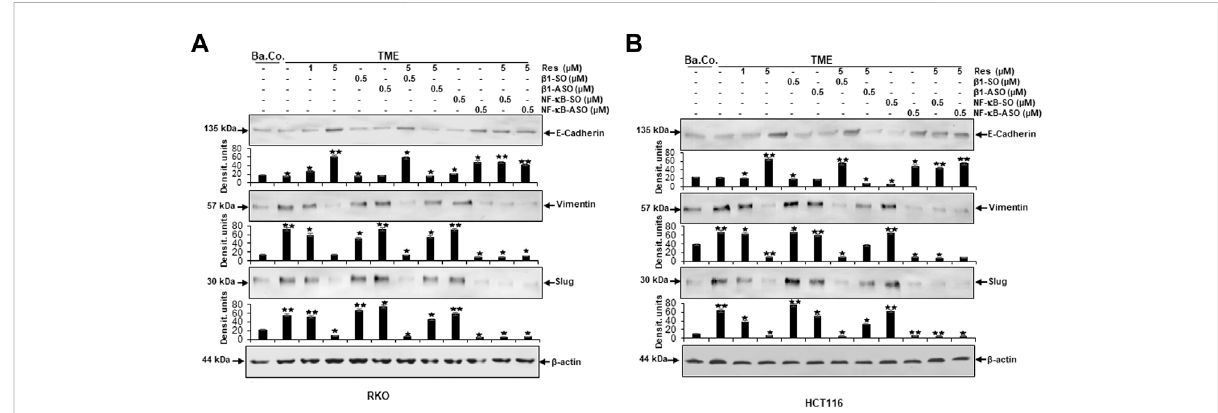
FIGURE 8 Impactofresveratrolor/andASOagainst β 1-integrinoragainstNF- κ BonTME-promotedactivationofEMT-linkedbiomarkersinCRCcells.3D- alginate RKO (A) and HCT116 (B) CRC cells were detected against E-cadherin, vimentin, slug and loading controlled with β -actin after 10 – 14 days of treatment. X -axis:untreated(Ba.Co.),TMEcontrol,resveratrol(1,5 µM), β 1-SO/ASO(0.5 µM),NF- κ B-SO/ASO(0.5 µM)orcombinationof0.5 µMSO/ ASO and resveratrol (5 µM). Y -axis: Densitometric units ( y -axis) complementing Western blot results and for analysis, data were compared to TME control: * p < 0.05 and ** p < 0.01 were considered statistically signi fi